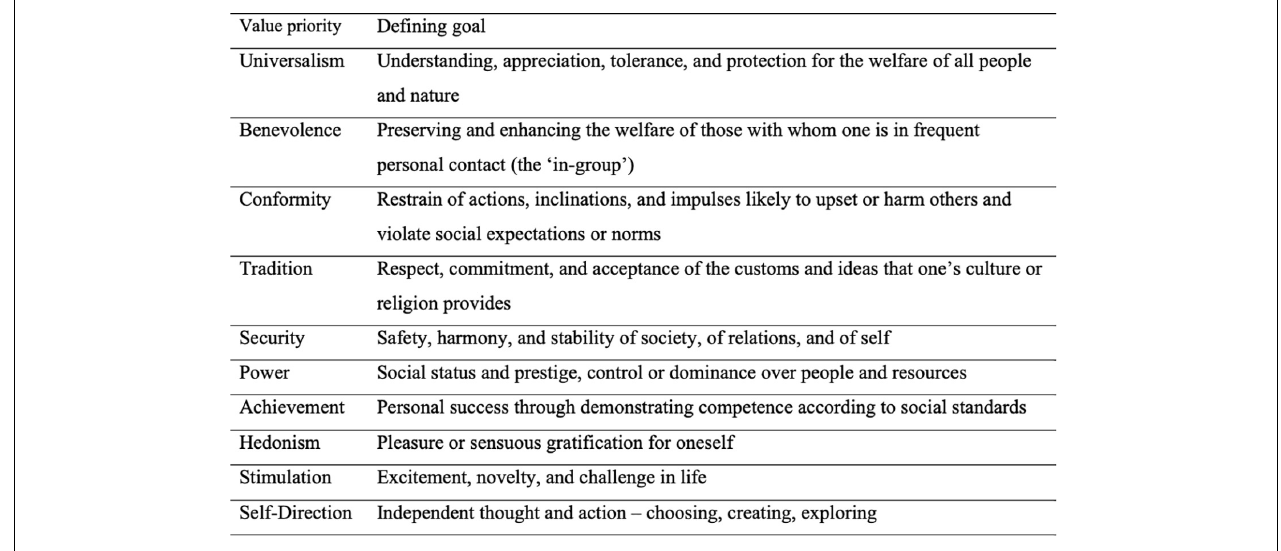
FIGURE 1 | Value priorities and their defining goals (adapted from Schwartz, 1992).